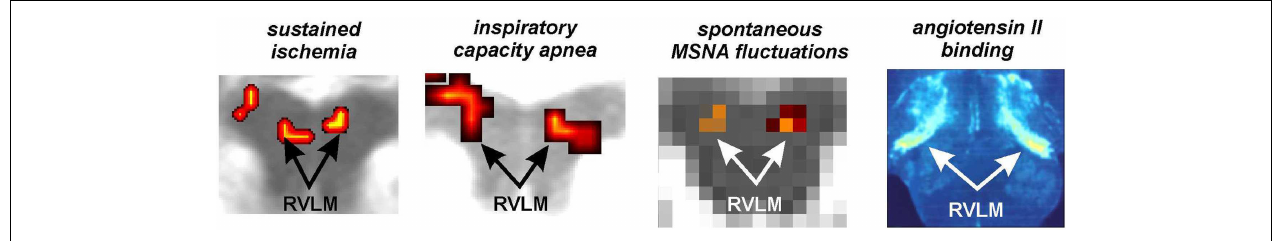
breath-hold (Macefield et al., 2006), spontaneous fluctuations in muscle sympathetic nerve activity (MSNA) (Macefield and Henderson, 2010), anatomical identification of the RVLM using the binding of Angiotensin II receptors (reproduced with permission from Allen et al.,